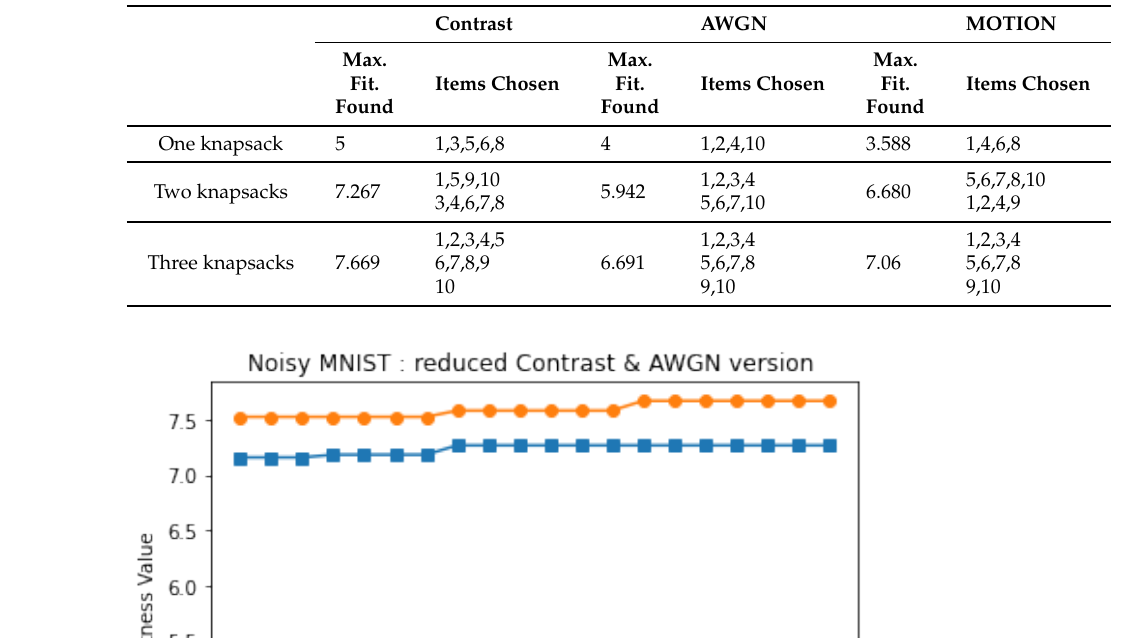
Table 4. The chosen items for different numbers of knapsacks with the max fitness found.